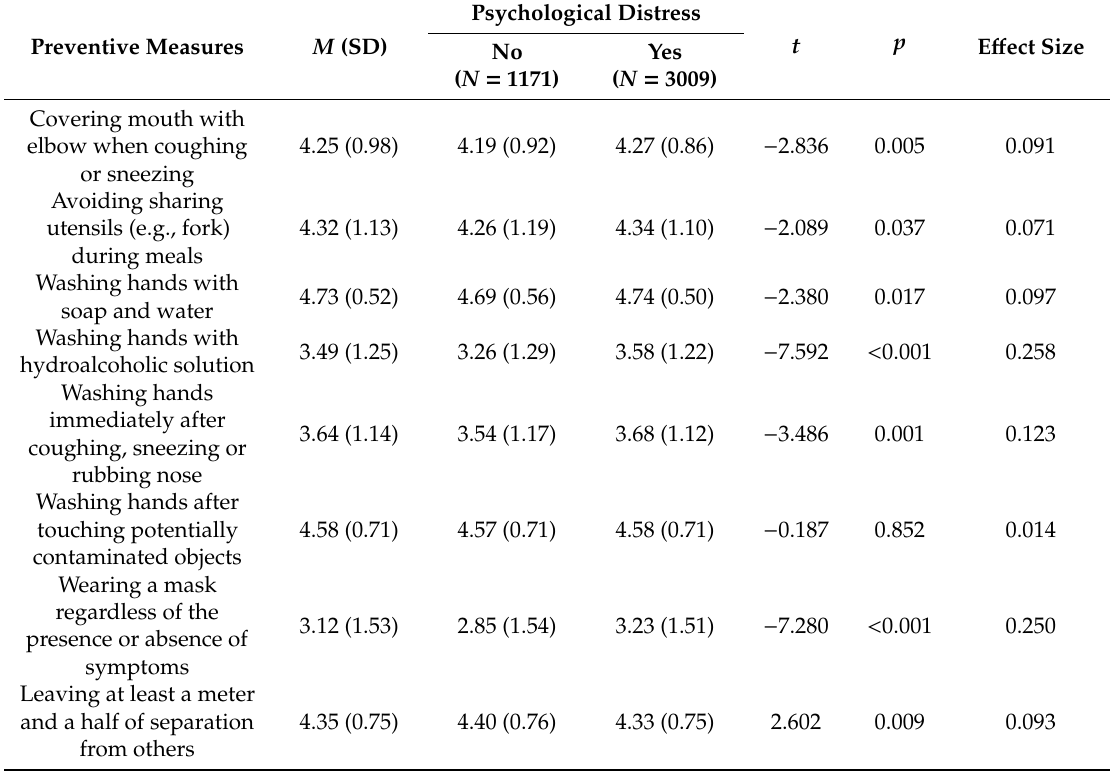
Table 3. Association between preventive measures and psychological distress during the COVID-19 pandemic ( n = 4180).